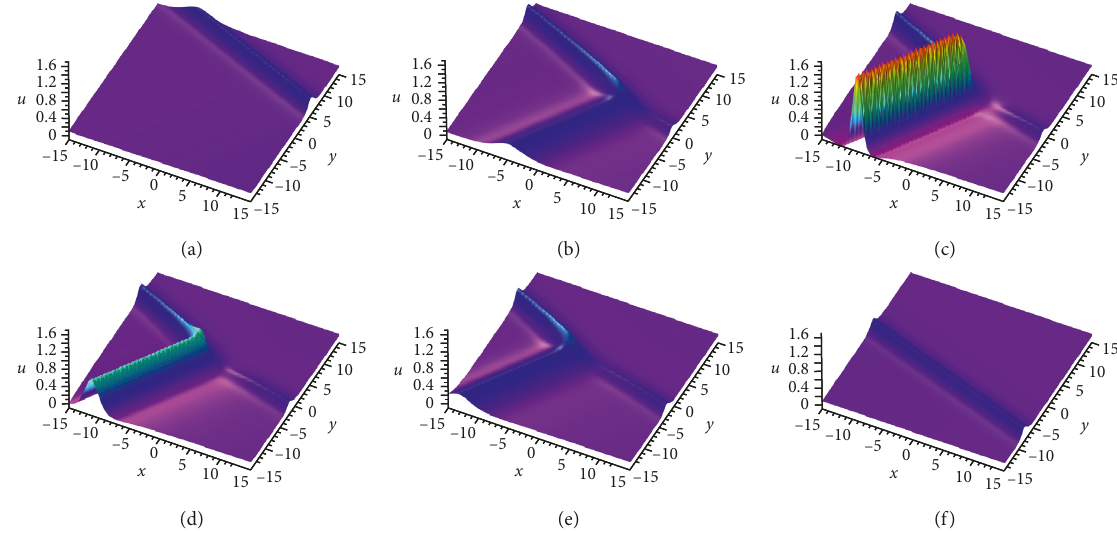
Figure 5: The propagations of the interaction solution between a rogue wave and bright soliton (2) with (11) and (14) taking the parameters � 2, a � 5/2, a � − 3, k � 1, a � − 1, and a � 3 at different times (a) t � − 30, (b) t � − 10, (c) t � − 3 . 3, (d) t � 0, (e) t � 3 . 3, and (f) m 0 4 8 1 2 3 t �